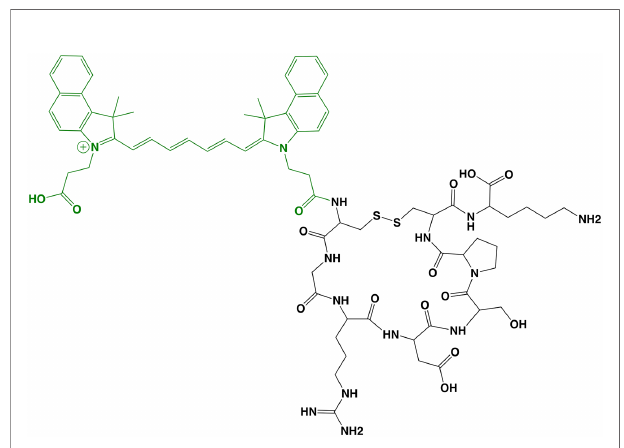
FIGURE 6 | LS301. Chemical structure; c(CGRDSPC)K-OH (ligand) in black, cypate (dye)